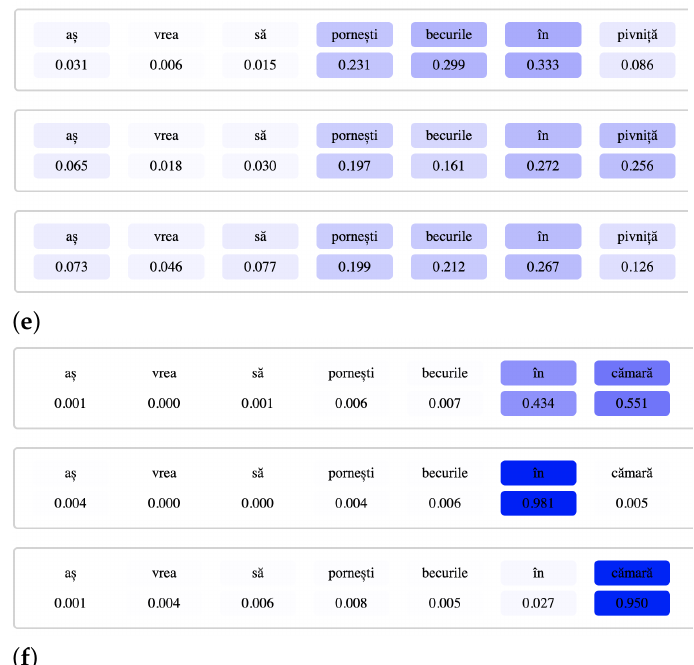
vrea s˘a pornes ti becurile în ...” / “I’d like you to turn on the lights in ...” , ,